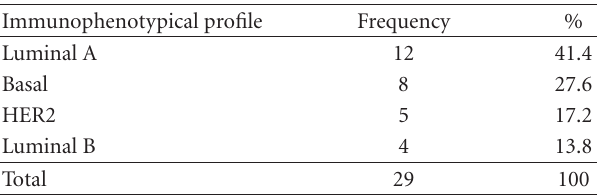
Table 6: Immunophenotypical profile distribution of the invasive component ( n =